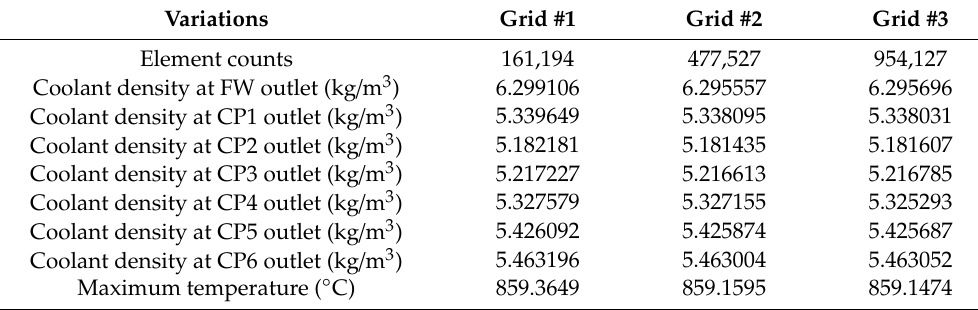
Figure 9. The 2D HSCB thermal-hydraulics model. Table 4. Thermal-hydraulics results comparison of the HCSB with di ff erent